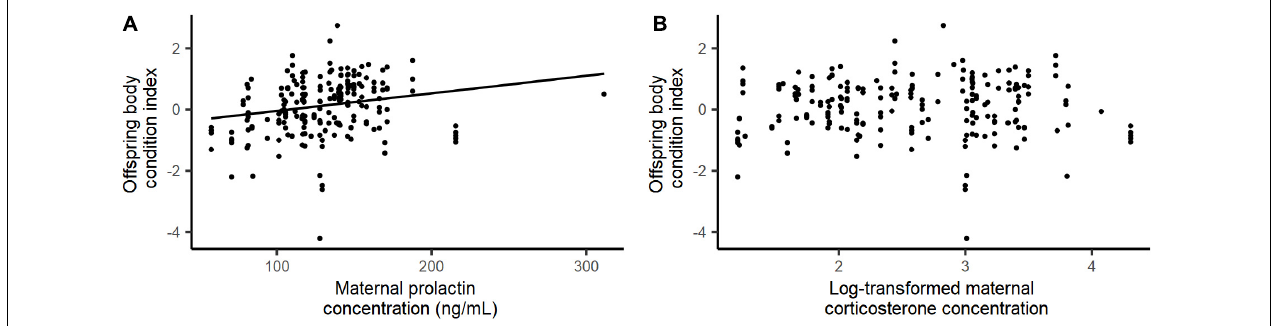
FIGURE 5 | Relationship between the duckling body condition index and maternal baseline concentrations of (A) prolactin and (B) corticosterone (log-transformed) in eiders.